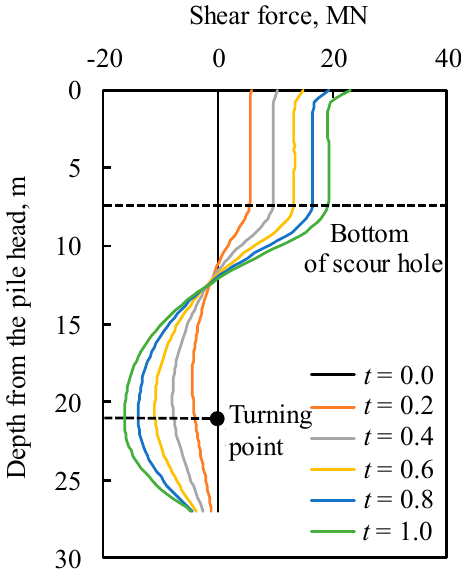
Figure 7. Shear forces along the pile during the lateral loading.